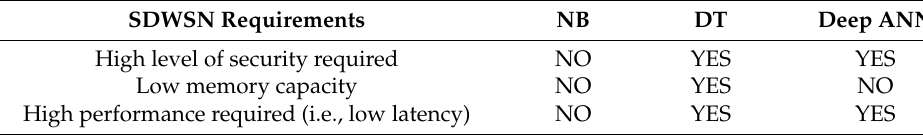
Table 15. Requirements and Application Examples.